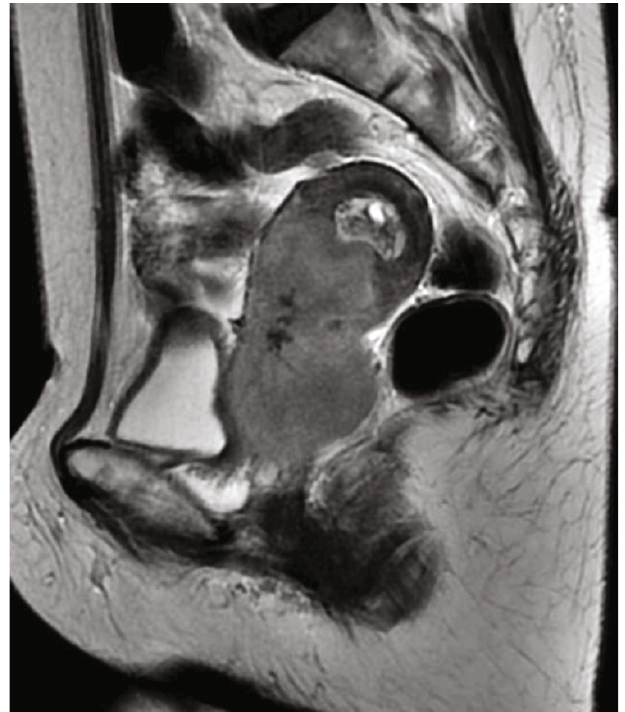
Figure 1: Magnetic resonance imaging (MRI) fi ndings of primary disease. T2-weighted MRI showing locally advanced cervical cancer that extended into the endometrium.